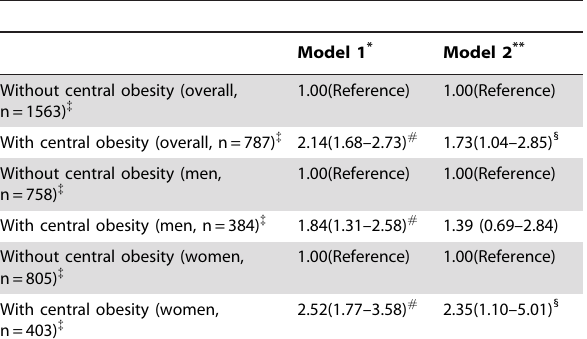
Table 3. Unadjusted and adjusted odds ratios (95% confidence intervals) of having albuminuria derived from a multiple logistic regression analysis using central obesity as independent variables in the baseline cohort, adjusted for potential confounders { .